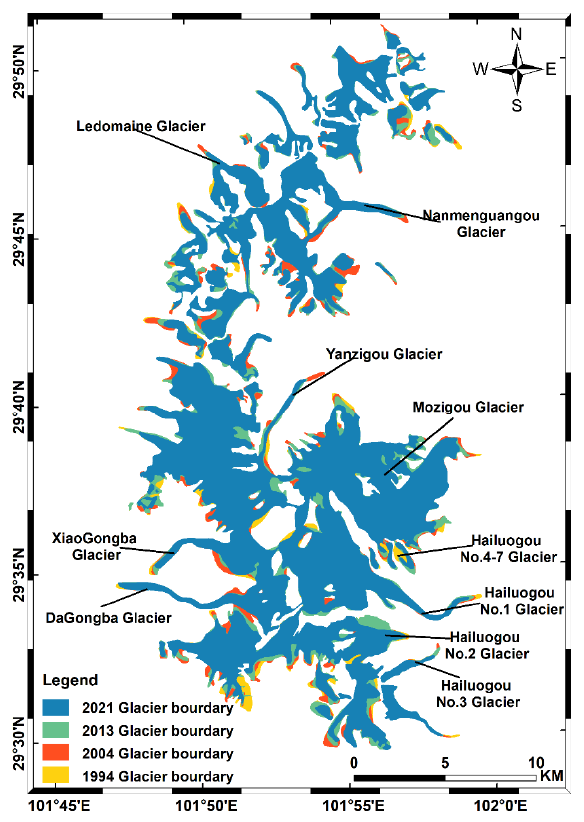
Figure 3. The boundary of glaciers in 1994, 2004, 2013, and 2021.